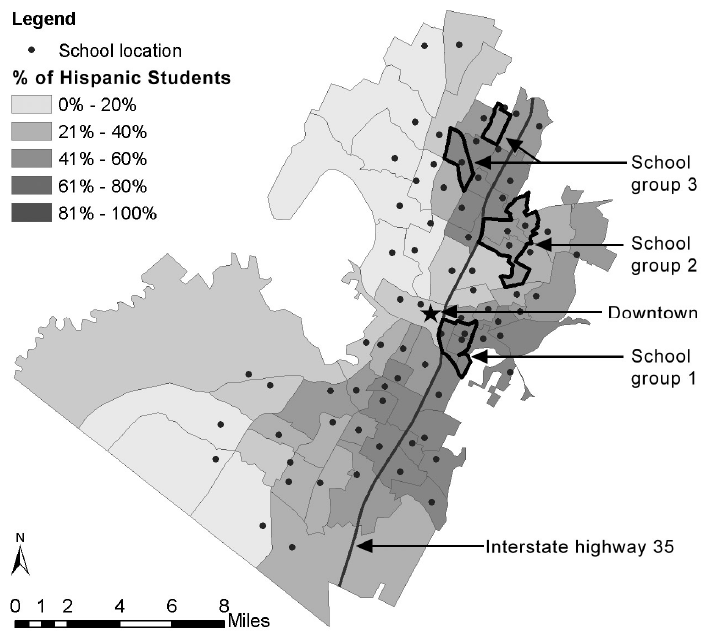
FIGURE 2. Percentage of Hispanic students within elementary schools in the AISD and locations of sampled